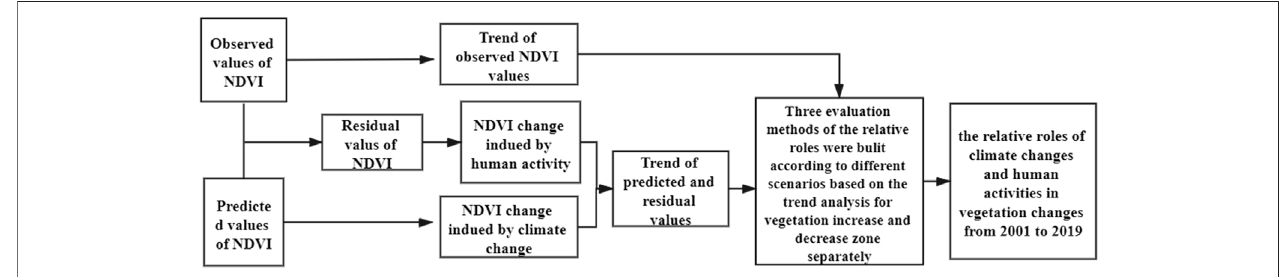
FIGURE 2 | Flow chart of the process for assessing the relative roles of climate variations and human activities in the process of vegetation cover change.